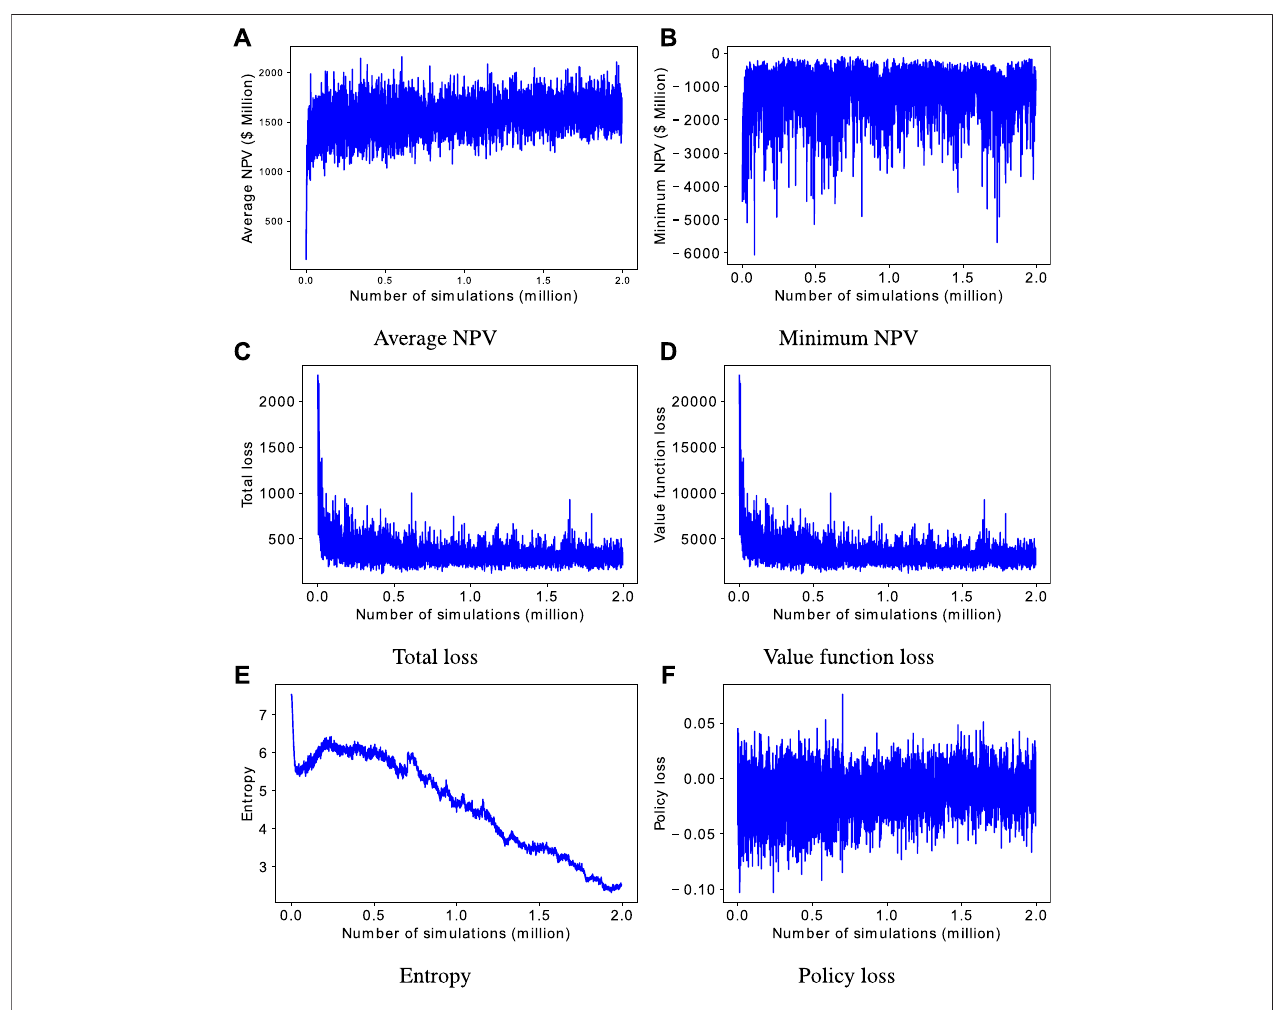
FIGURE 10 | Evolution of training performance metrics for the dual-action probability distributions for the 3D